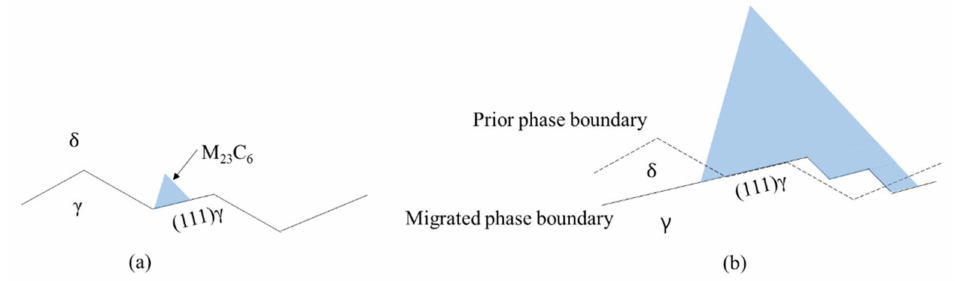
Figure 3. Schematic diagram of M 23 C 6 nucleation and growth on phase boundary: ( a ) nucleation of M 23 C 6 on (111) plane of γ boundary; ( b ) growth of the M 23 C 6 on the migrating faceted phase